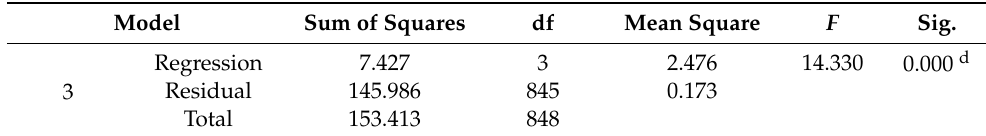
Table 8. Analysis of variance of the selected